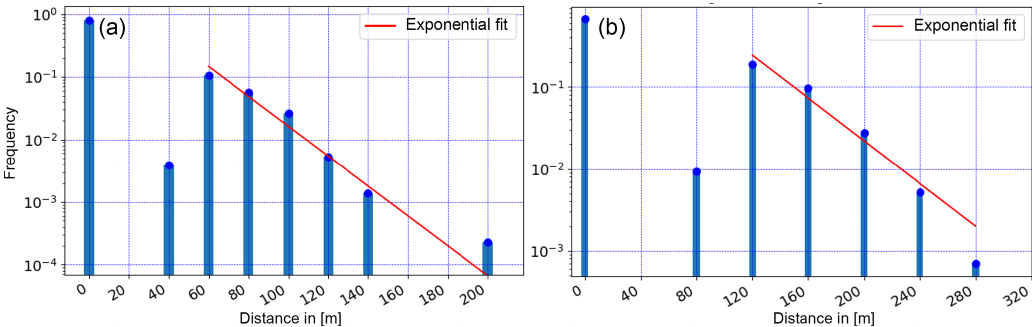
Figure 8. Histogram of the transport distance of all blowing snow events for (a) EP1 (Fig. 5a) and (b) EP2 (Fig. 7a), including exponential fits for distances larger than the minimal transport